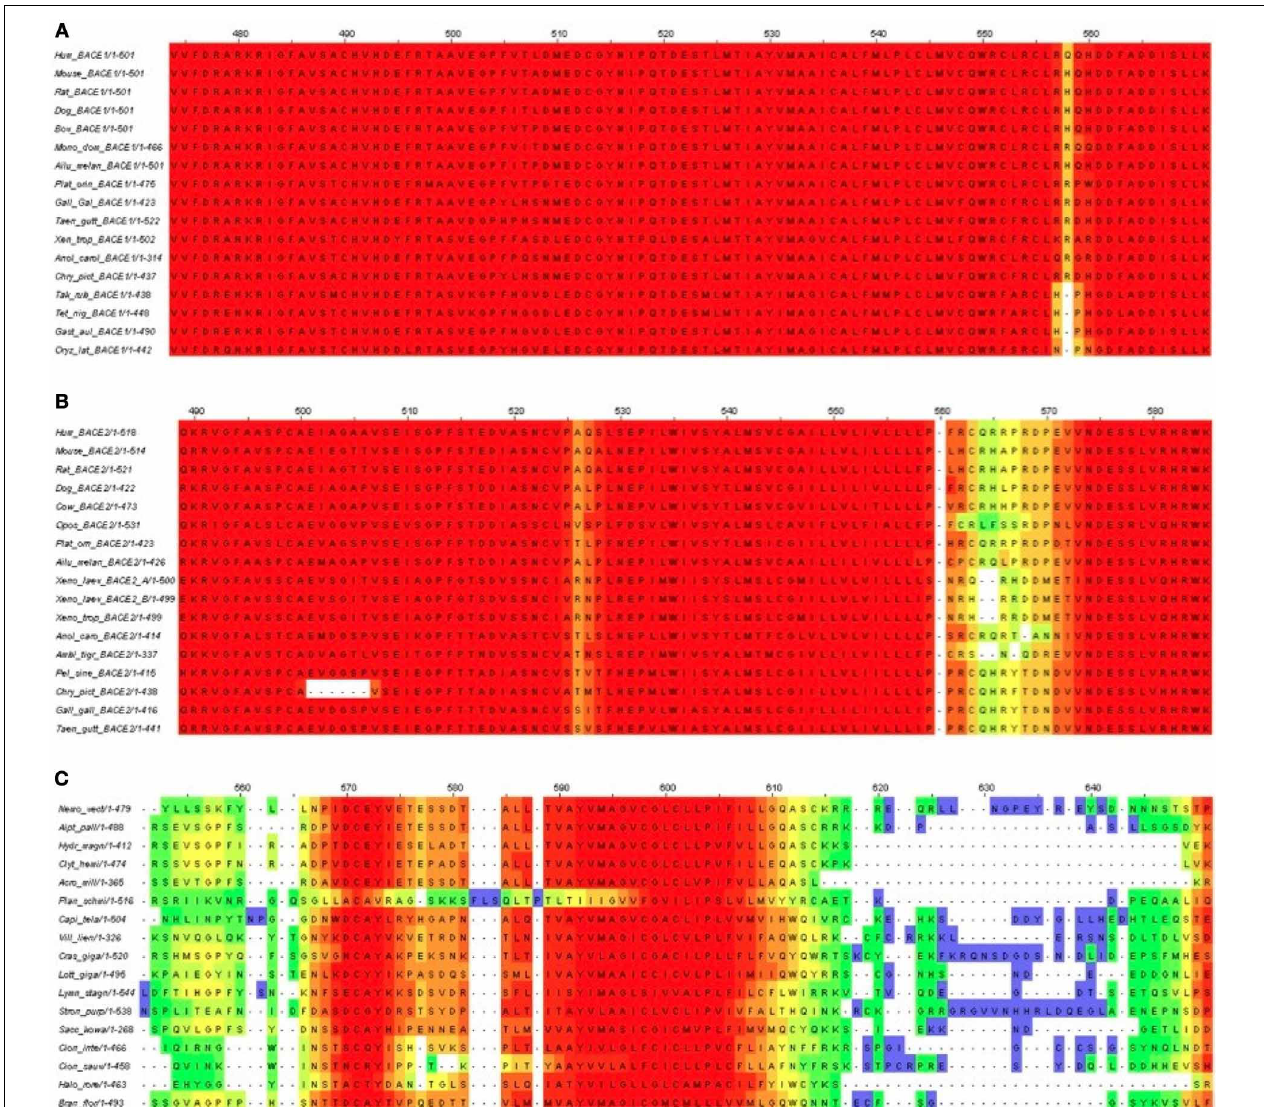
FIGURE 7 | T-Coffee alignments of C-termini for (A) BACE1, (B) BACE2, and (C) UrBACE. The inputs were restricted to complete termini but also needed the removal of the Monosiga and Trichoplax sequences to give an informative result for panel (C)